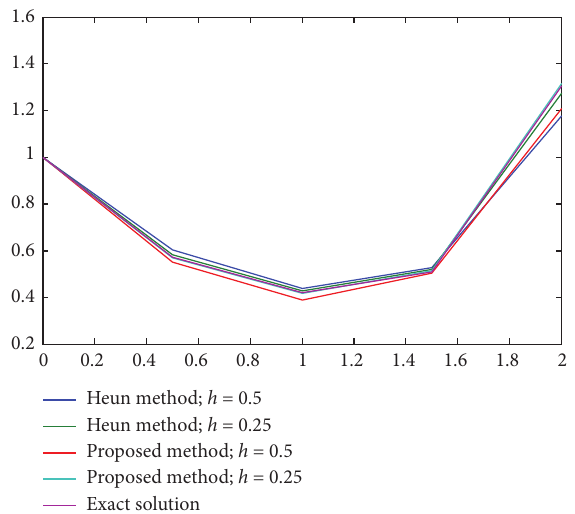
Figure 7: Errors made by the stated methods for Example 1.